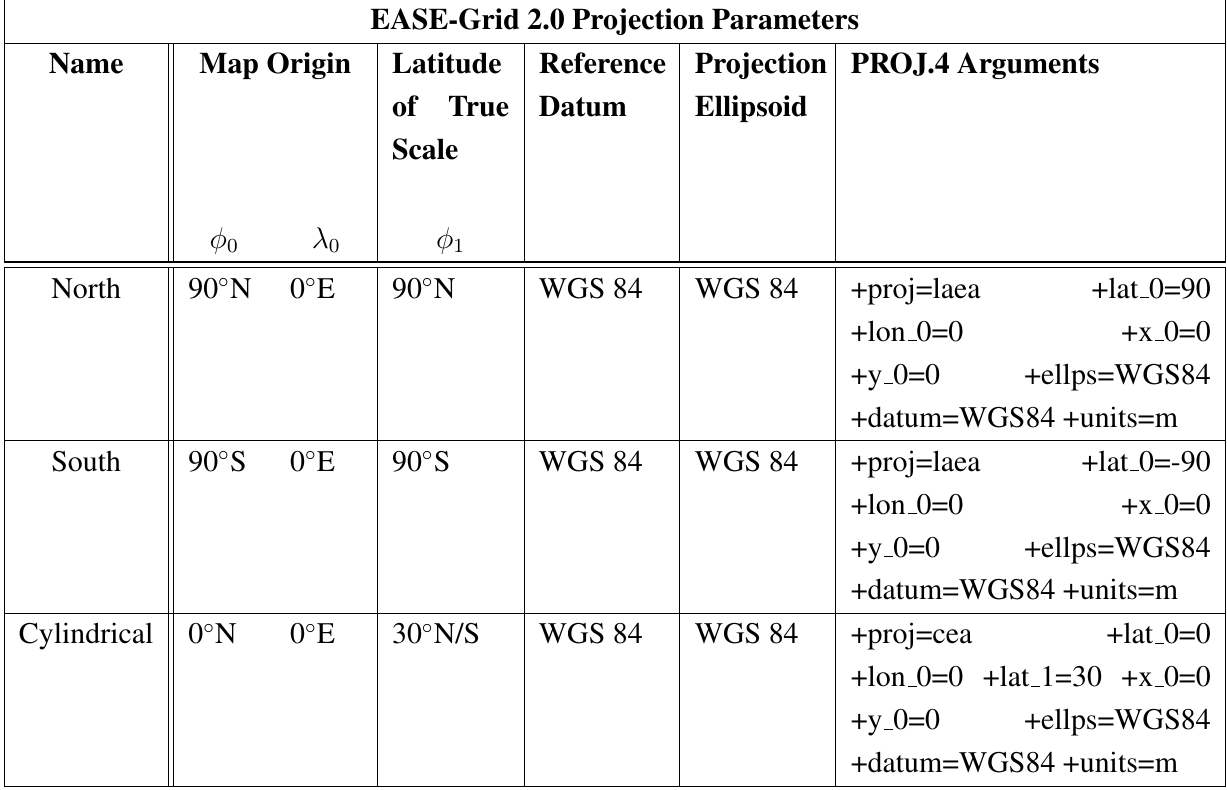
Table 2. PROJ.4 library EASE-Grid 2.0 projection